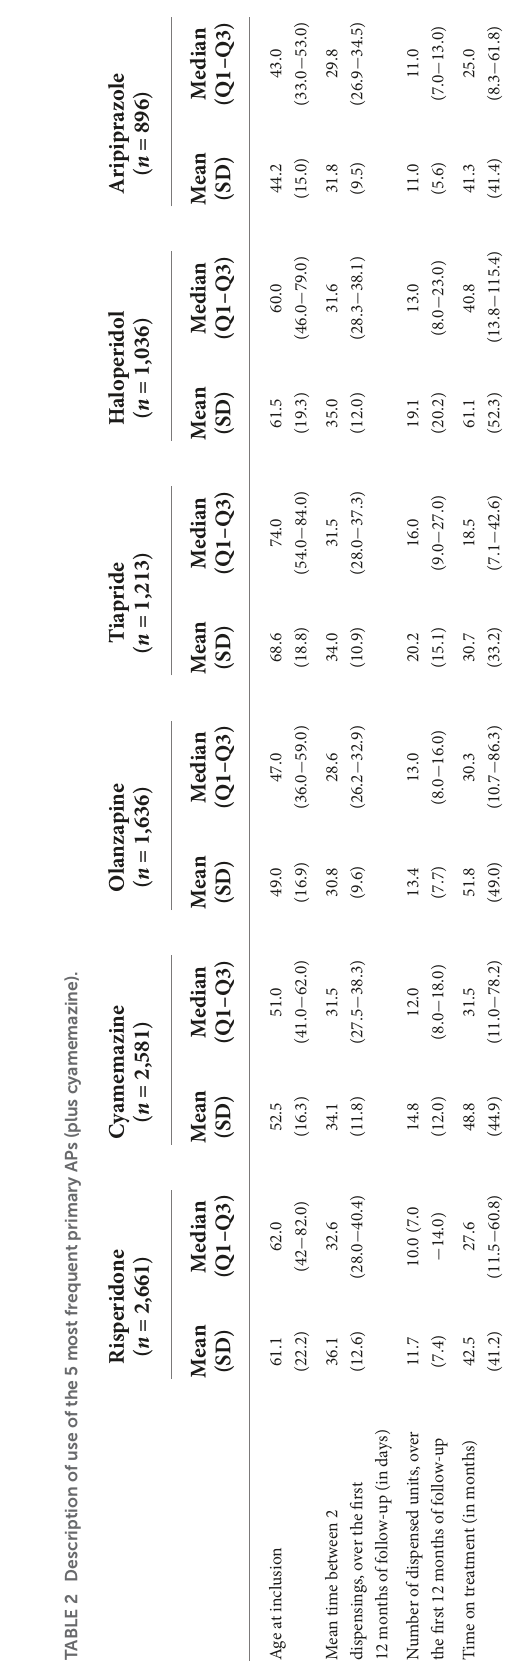
TABLE 1 Distribution and use of primary antipsychotics ( n =